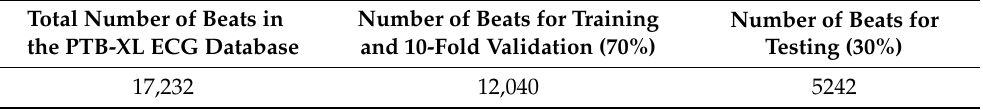
Table 3. Detailed splitting of the data to validate the proposed method.